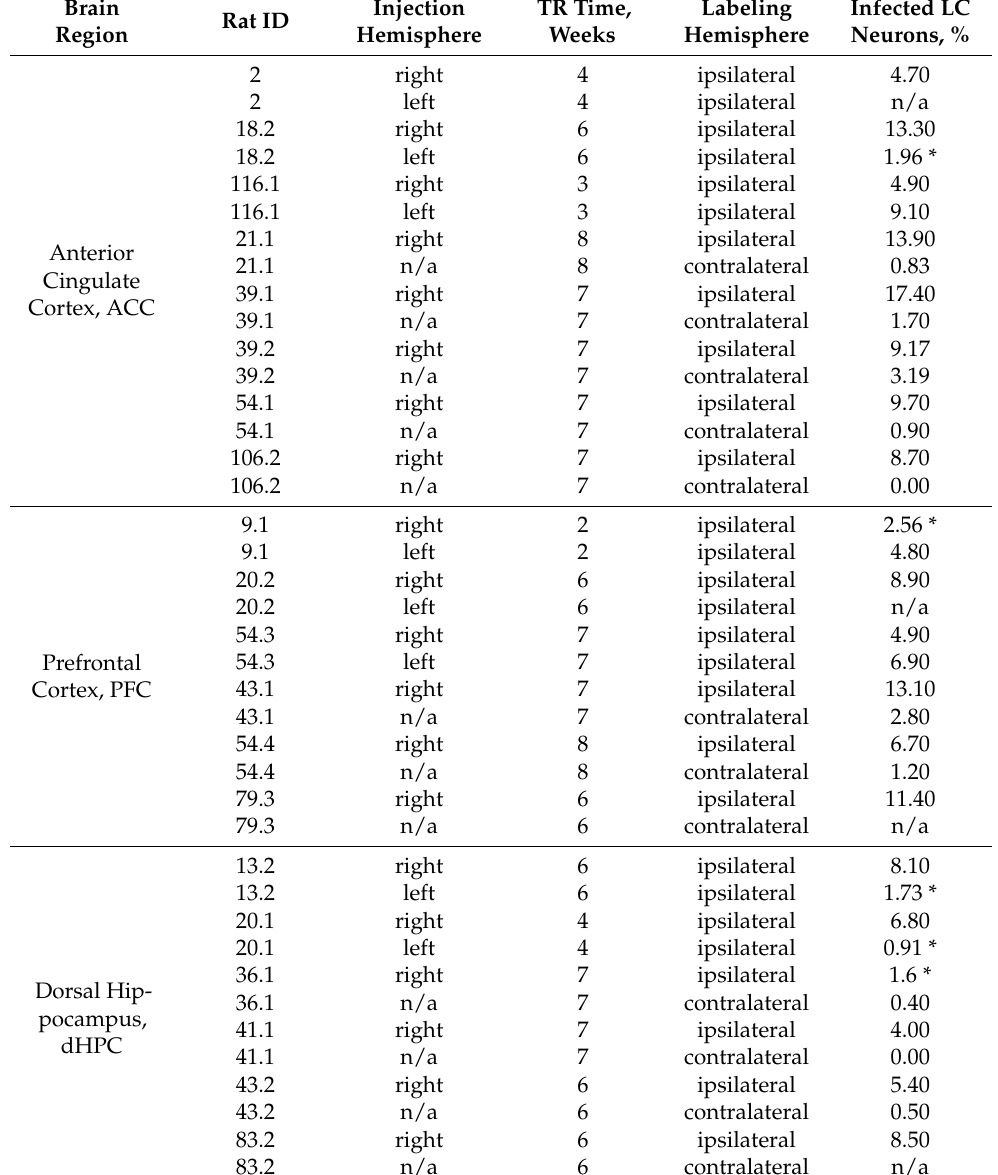
Table 2. Summary of the LC-NE neuron transduction via retrograde transport from the